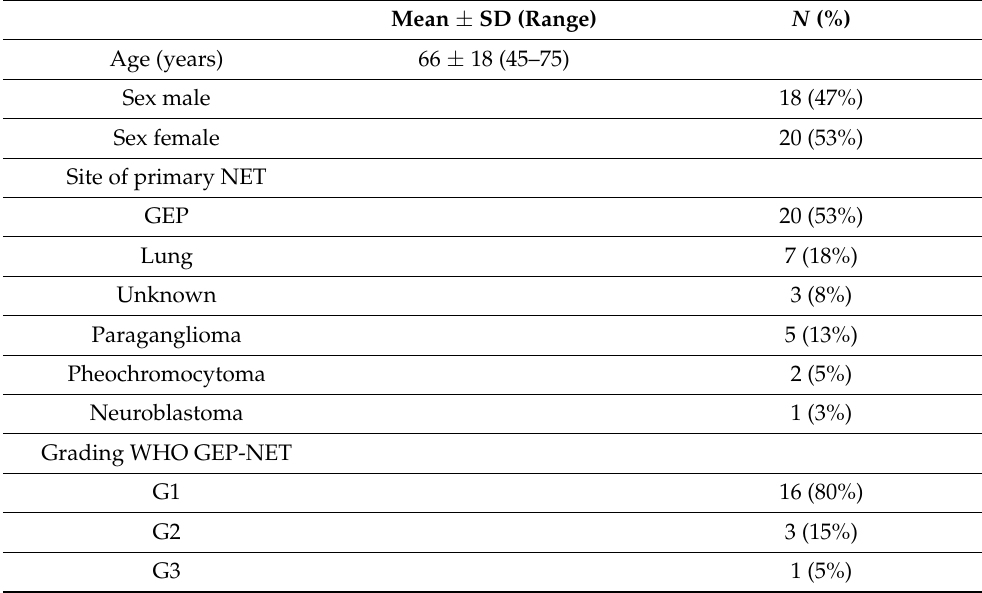
Table 2. The main features of 38 patients with incidental brain uptakes confirmed as meningioma.